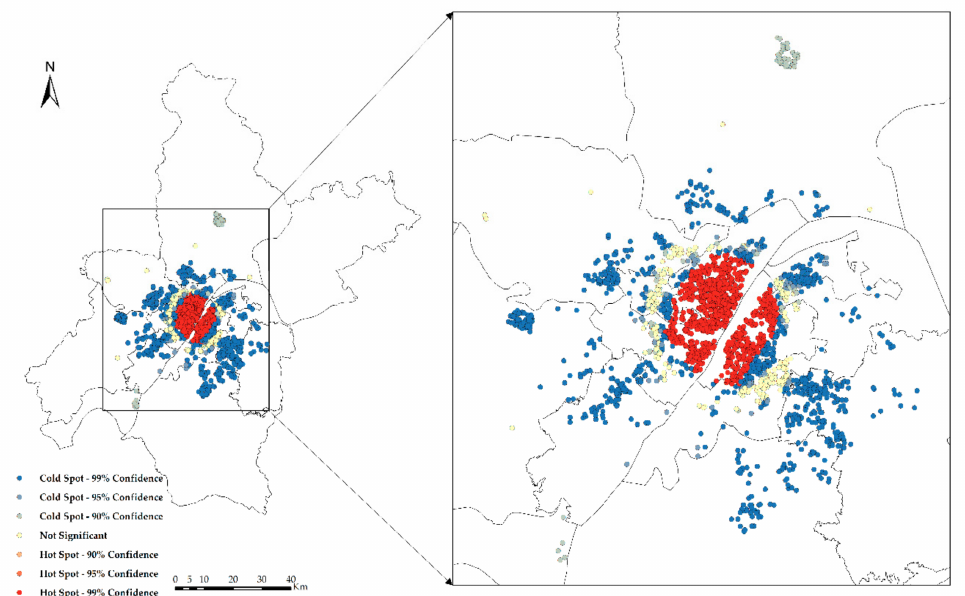
Figure 11. Hotspot analysis of the NTLI.